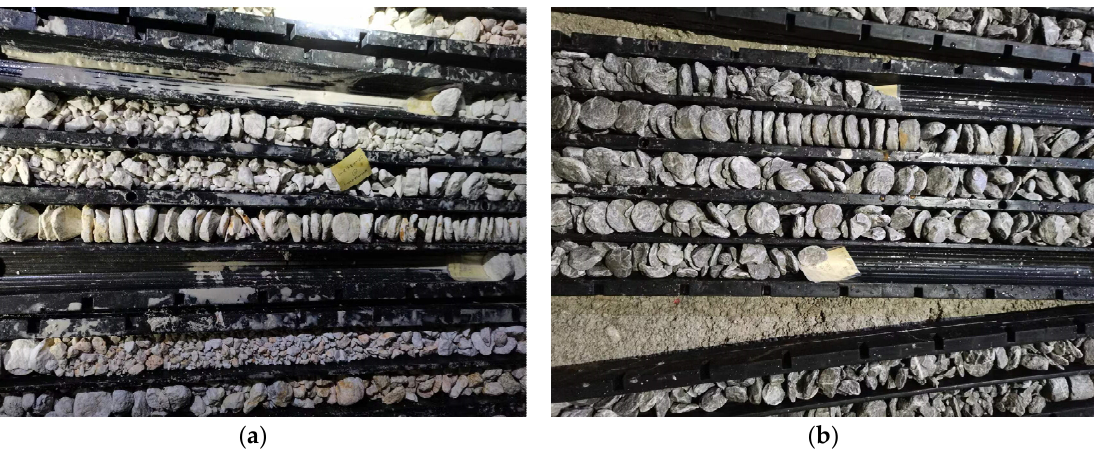
Figure 1. Core disking in a deep mine in China: ( a ) Mining depth of 950 m; ( b ) Mining depth of 1050 m.